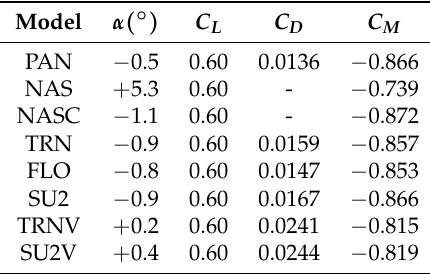
Table 7. Aerodynamic coefficients obtained by different levels of fidelity for the rigid Embraer Benchmark Wing at Mach 0.78 and lift coefficient